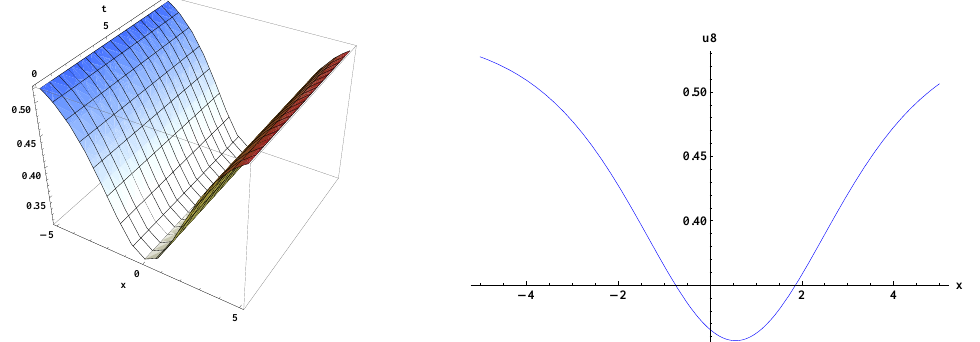
Figure 7. Dark solitary wave solution (24) ( left ) and its projections at t = 0 ( right ), when A 1 = 0.1, A 2 = 0.5, µ = 0.7, λ = 0.3, k = 0.2, δ = 1, and y = 0.5.